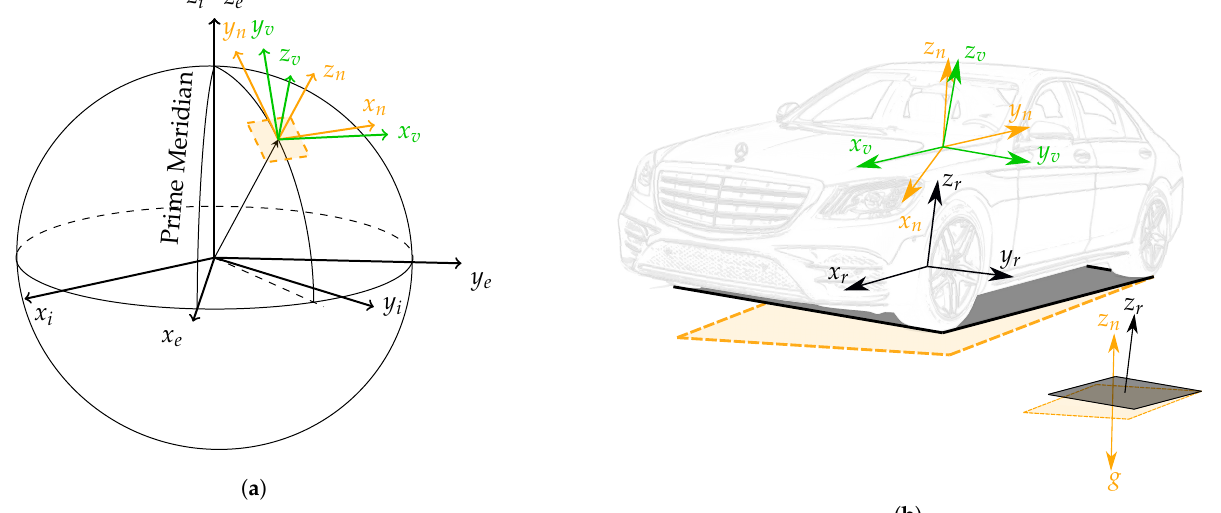
Figure 2. Representation of the inertial ( i ), ECEF ( e ), local navigation ( n ), vehicle ( v ) and road ( r ) coordinate systems. For a clear depiction, a world and vehicle perspectives are displayed, which corresponds with ( a , b ), respectively. The black and yellow planes respectively represent the road plane and the plane tangent to the Earth’s ellipsoid, which is considered to be normal to gravity. Please note that n and v share the same origin, and the origin of r lies on the road plane.